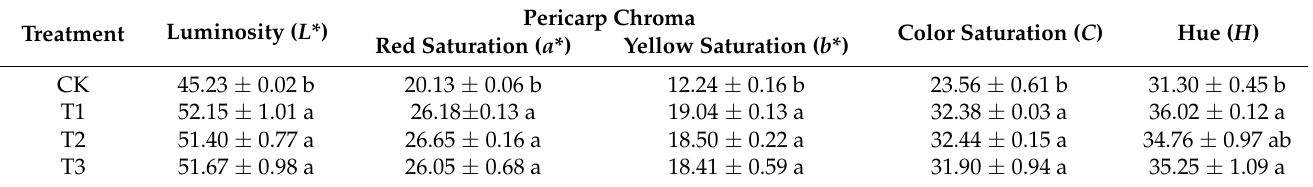
Table 4. Effect of different abaxial leafy supplemental lighting treatments on fruit color of cherry tomato. Treatment Luminosity ( L